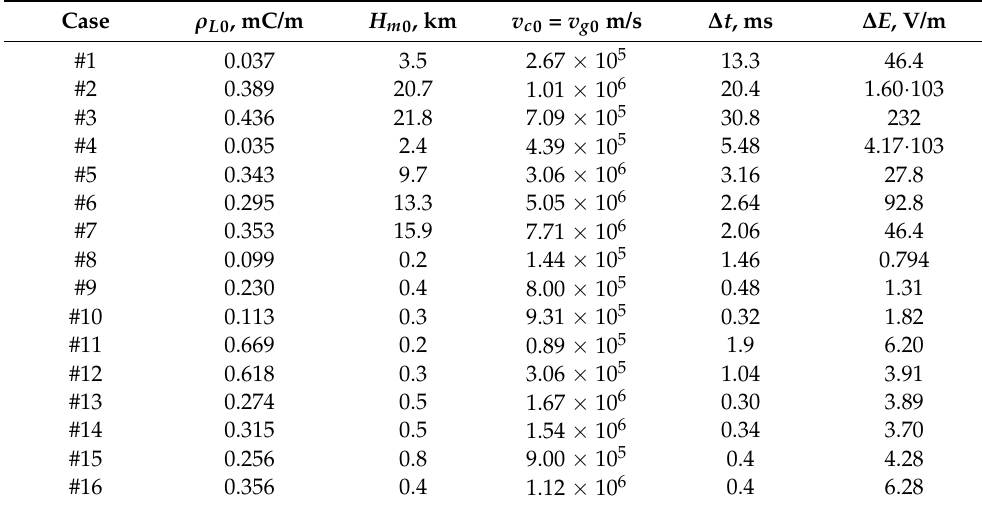
Table 2. Set of initial conditions used in simulations of positive lightning leader stages and remaining parameters ∆ t and ∆ E identified from the recorded E-field leader